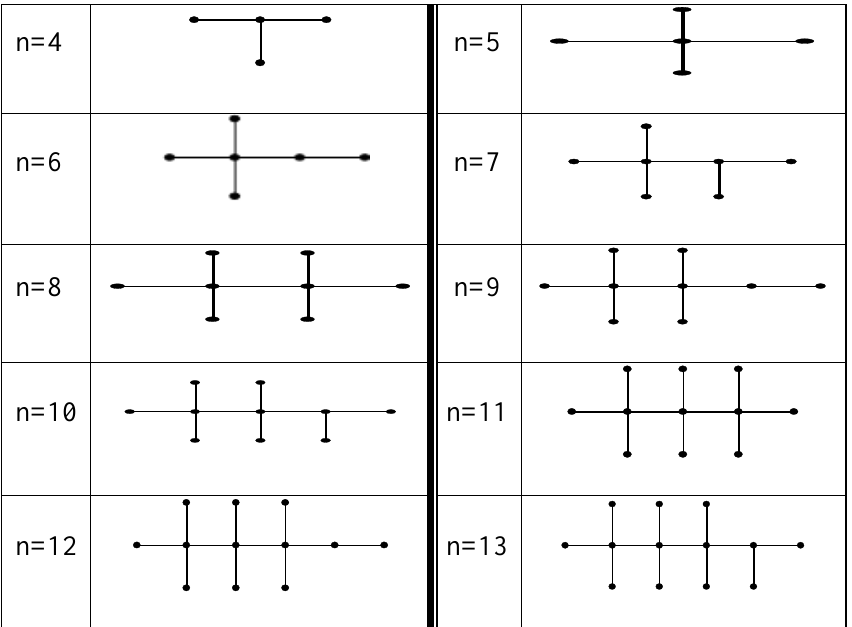
Table 2 . The Maximal Chemical Trees with respect to I Index, 4 ≤ n ≤